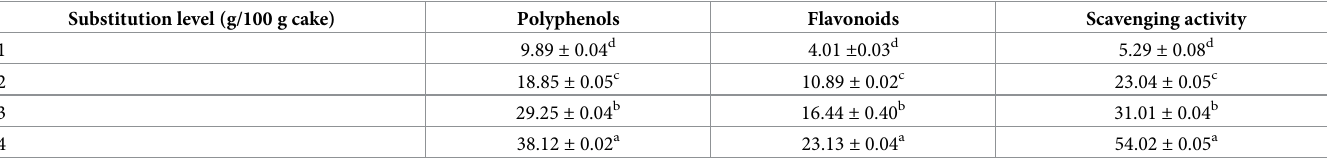
Each value in the table is represented as mean ± SD ( n = 5). a, b, c, d Values with the same superscript letters in the same line are non-significant at p < 0.05; polyphenols are expressed as mg gallic acid equivalents (GAE)/100 g cake; flavonoids are expressed as mg catechin equivalents (CE)/100 g cake; DPPH • scavenging activity (%) is determined at 0.1g/ml cake